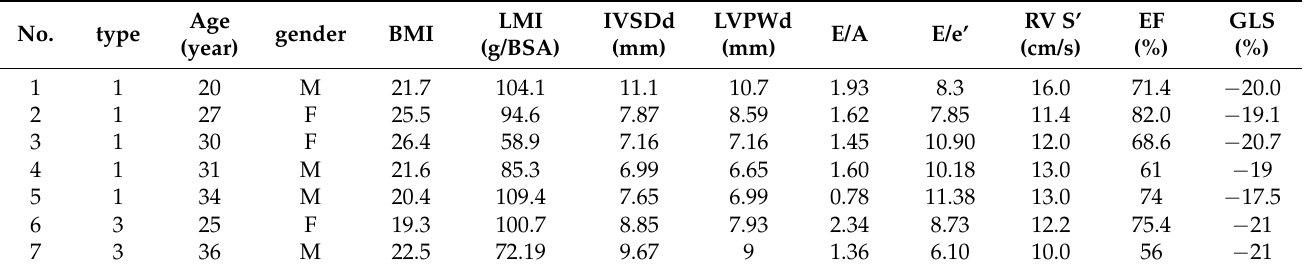
Table 5. Baseline characteristics and results of echocardiography in adult patients.